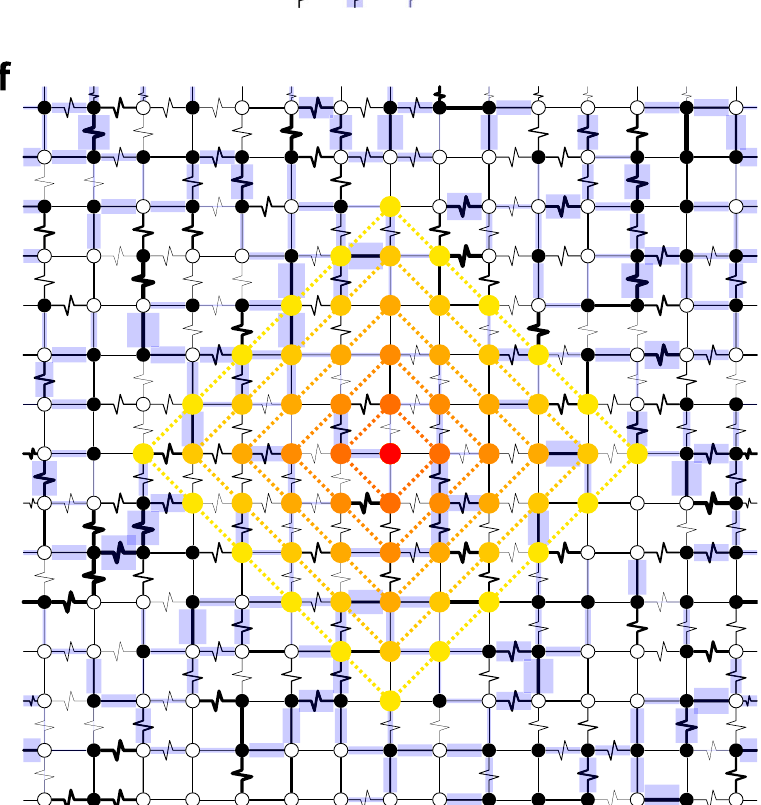
Fig. 3 | The encoder Spin Glass Neural Network (SGNN). SGNN encodes ( a ) the input spin glass instance (with any arbitrary spin con fi guration) into a ( e ) low- dimensionalspace,whereeachspinisassociatedwithanembeddingvector(shown as a color bar). b SGNN fi rst updates edge embedding vectors based on the edge itself and its adjacent nodes, and then ( c ) updates node embedding vectors based on the node itself and its adjacent edges. Note that the node-centric updates take place only when the edge-centric updates fi nish for all edges at each layer. Both updates are followed by a non-linear transformation operator (e.g., ReLU) with